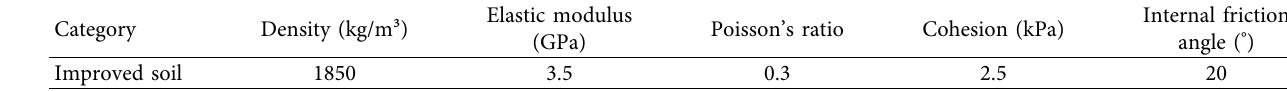
Table 2: Mechanical properties of embankments.